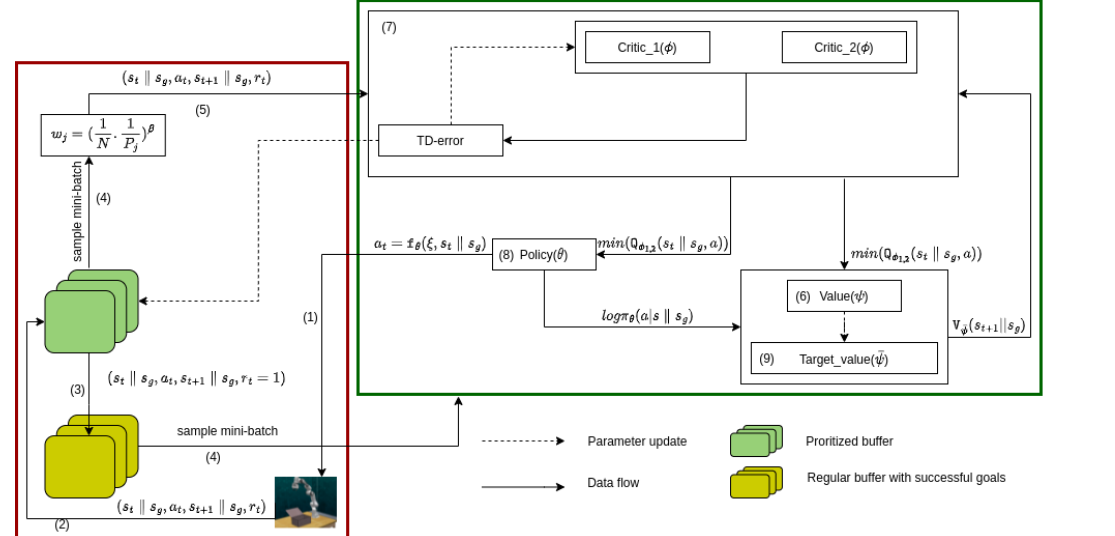
Figure 2. This figure describes the overall architecture of the proposed